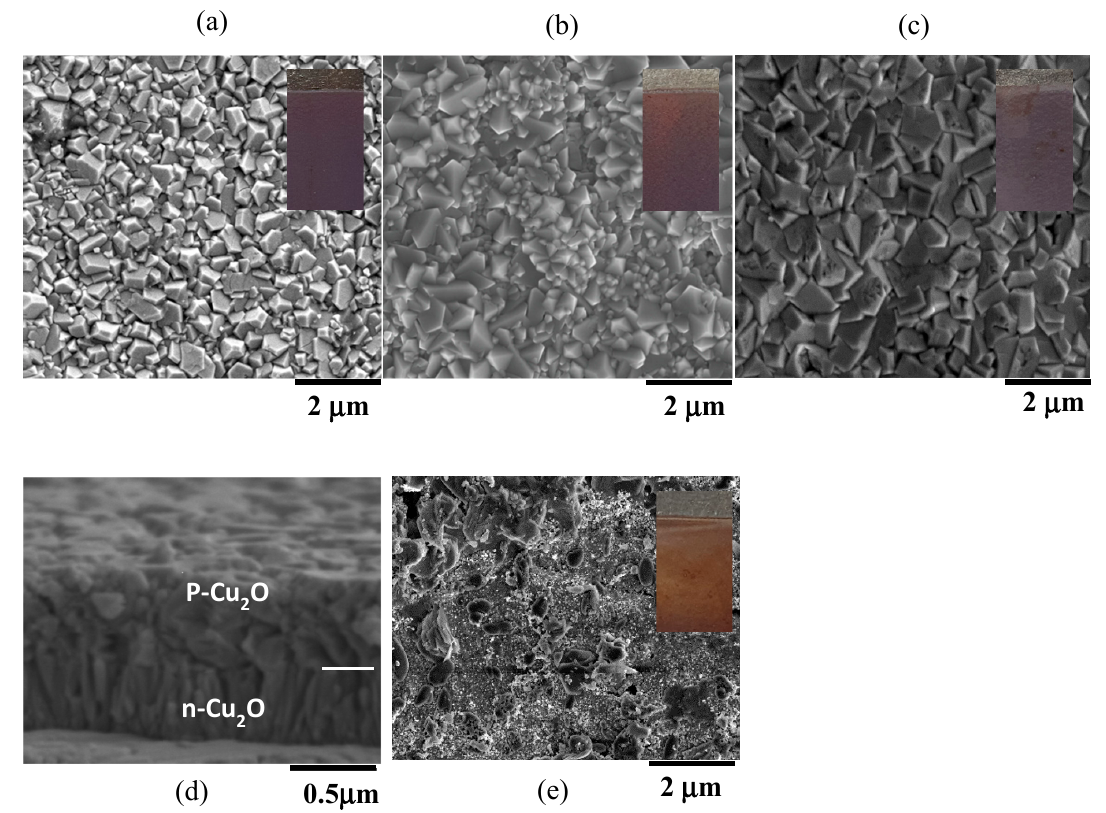
Figure 2. Scanning electron miscopy ( SEM) images of: ( a ) The top view n -Cu 2 O (pH 5.8), film on bare Ti substrate; ( b ) Top view p -Cu 2 O (pH 12.5) film on bare Ti substrate; ( c ) Top view of n -Cu 2 O/ p -Cu 2 O homostructure; ( d ) Cross-sectional view of n -Cu 2 O/ p -Cu 2 O homostructure. White horizontal line on the R.H.S marks the n -Cu 2 O/ p -Cu 2 O interface; and ( e ) Top view of sulfur-treated n -Cu 2 O/ p -Cu 2 O